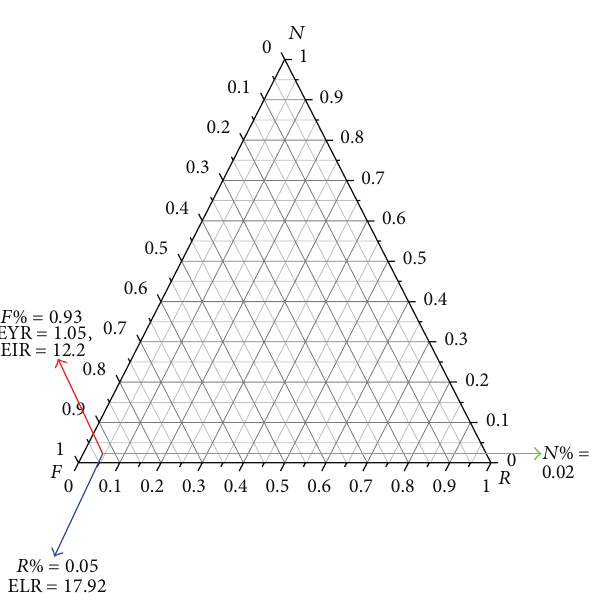
Figure 2: Resource flow lines in the emergetic ternary diagram.